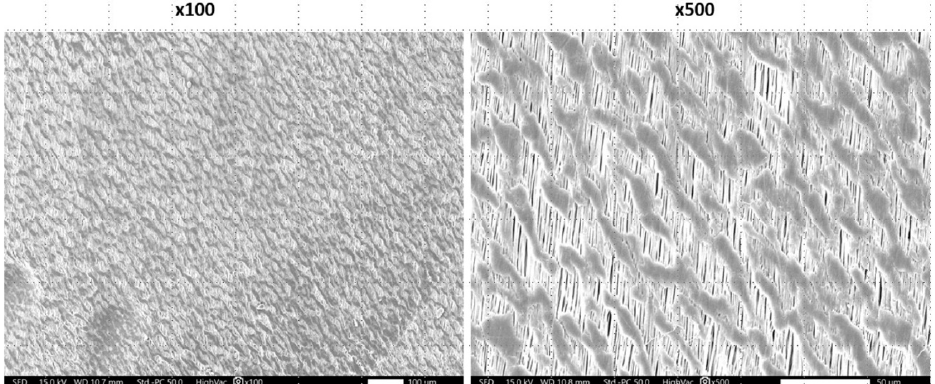
Figure 3. NeoGen ® membrane. SEM images of the bone-facing site.